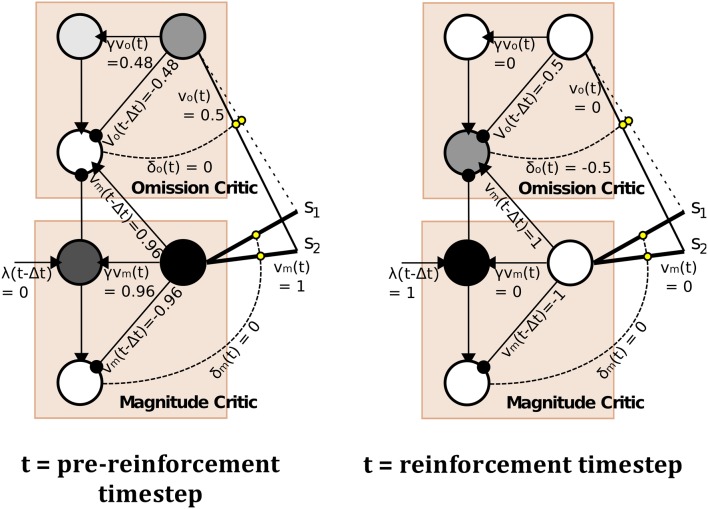
Differential outcomes computations. Computations of the Critic following learning of the value of a particular stimulus (0.5 omission probability of reinforcement of magnitude value 1.0). Left: At the time step prior to reinforcer presentation. Right: At the timestep of reinforcer presentation. Darker nodes represent greater activation; black, full activation of 1; white, zero activation. See Equations (A1, A2, A6, A7) for computation equations and text for explanation.